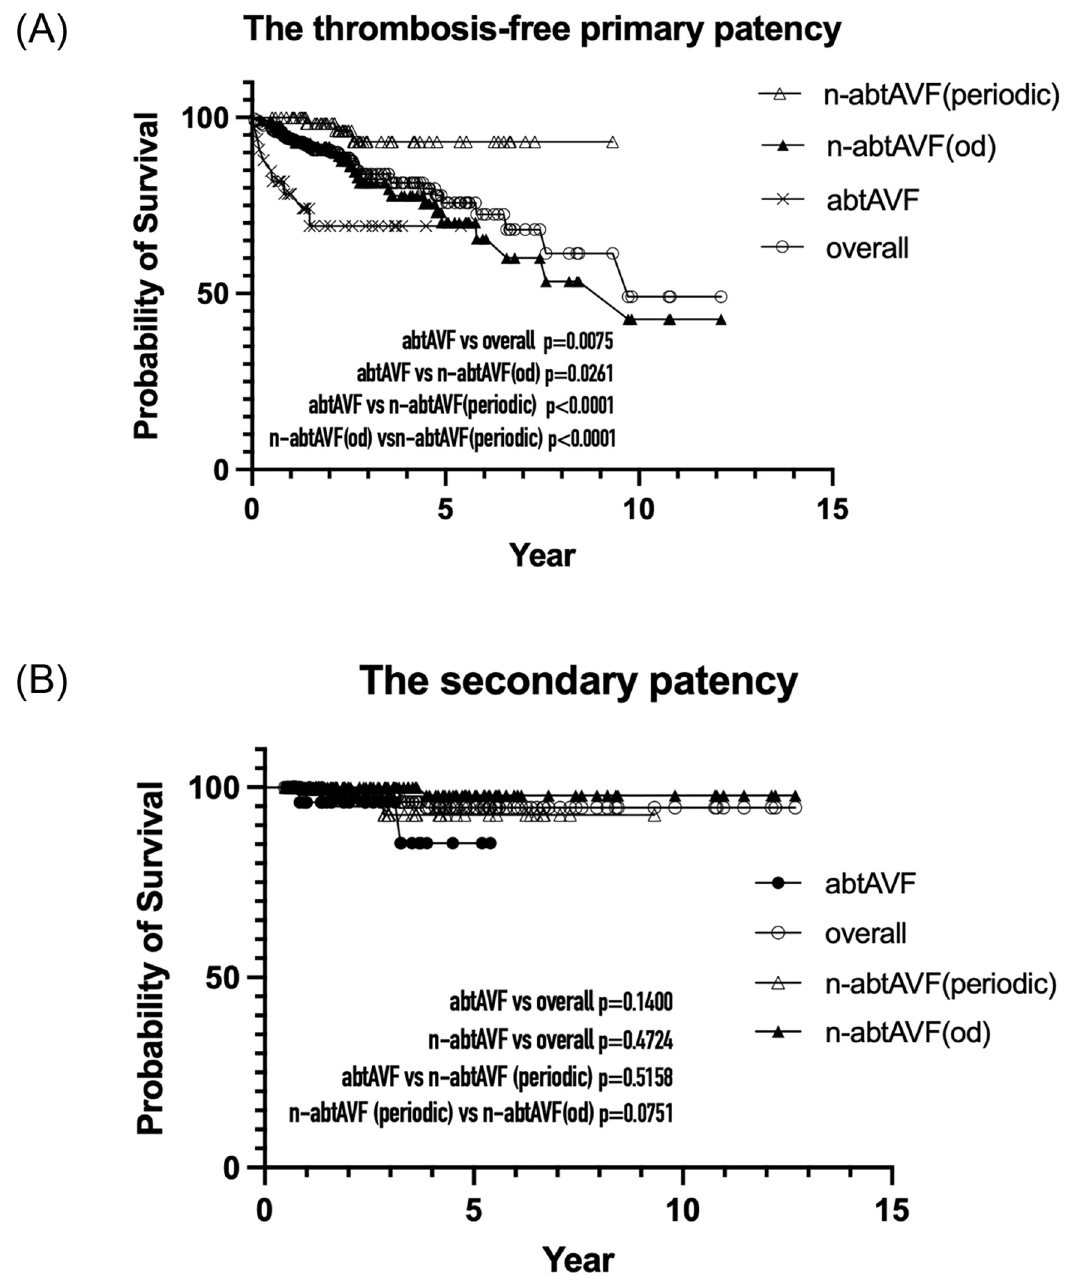
Fig 7. The Kaplan–Meier survival curves for the target follow-up groups. (A) The abtAVF group had the lowest 1-year thrombosis-free primary patency, and the n-abtAVF(periodic) group had the highest. (B) The secondary patency of the abtAVF group did not differ statistically from other target